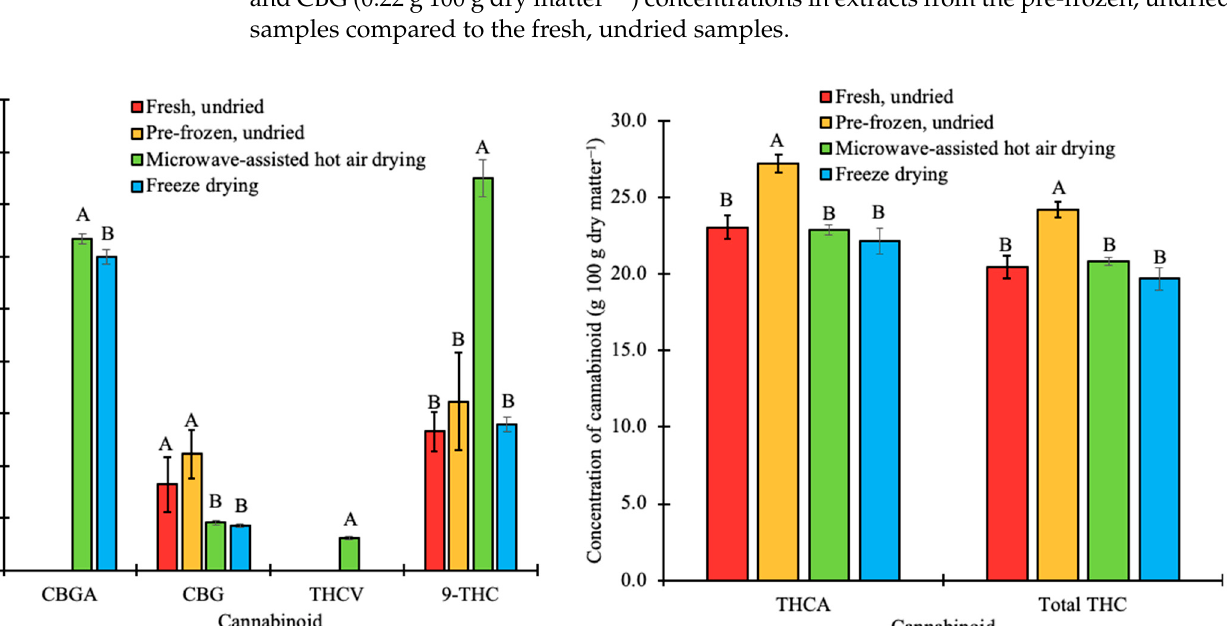
likely because CBGA serves as the precursory molecule to the other cannabinoids